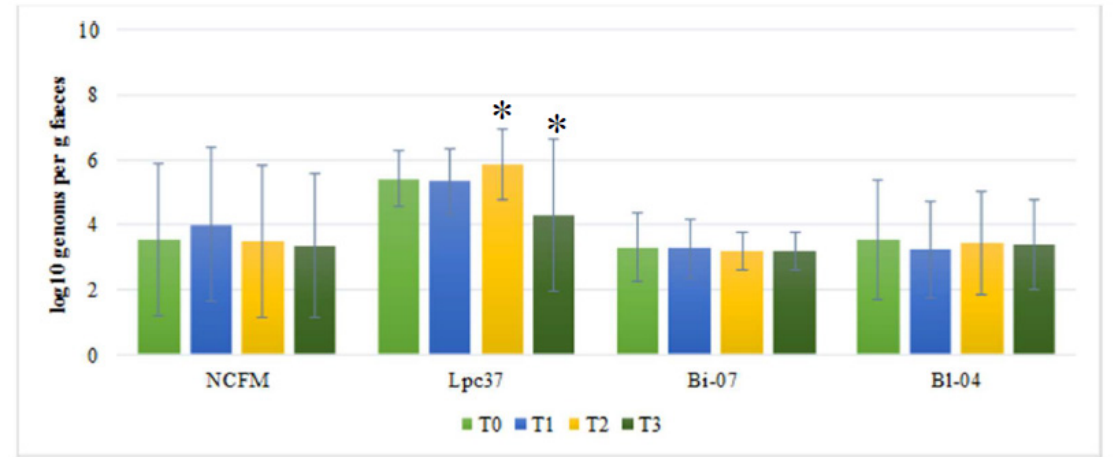
Figure 3. Mean levels ( ± SE) for Log10 detected genomes per gram feces for the target strains; Lactobacillus acidophilus NCFM, Lactobacillus paracasei Lpc-37, Bifidobacterium lactis Bi-07, and B. lactis Bl-04 in the placebo group for the four sampling times. Where T0 = baseline, T1 = end of antibiotic treatment, T2 = end of Placebo treatment, and T3 = one week after end of placebo treatment (washout). * Indicates significant changes from previous time point.